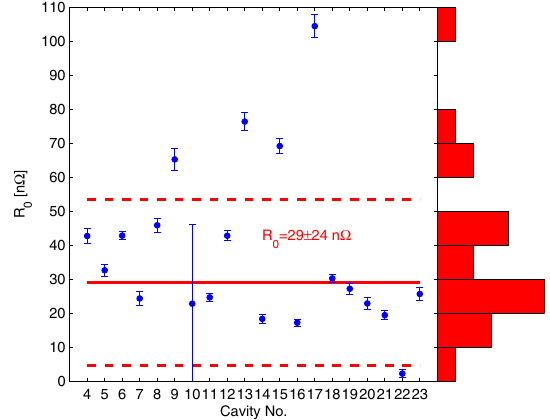
FIG. 13. Residual resistance estimation for all measured cavities. The label indicates the weighted average and the standard deviation of mean values.